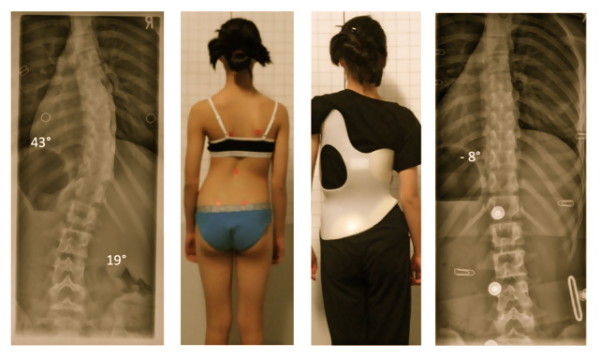
Corrective movement in the Gensingen brace™. In immature patients and single curve patterns an overcorrection is not rare. (With kind permission by Pflaum, Munich)